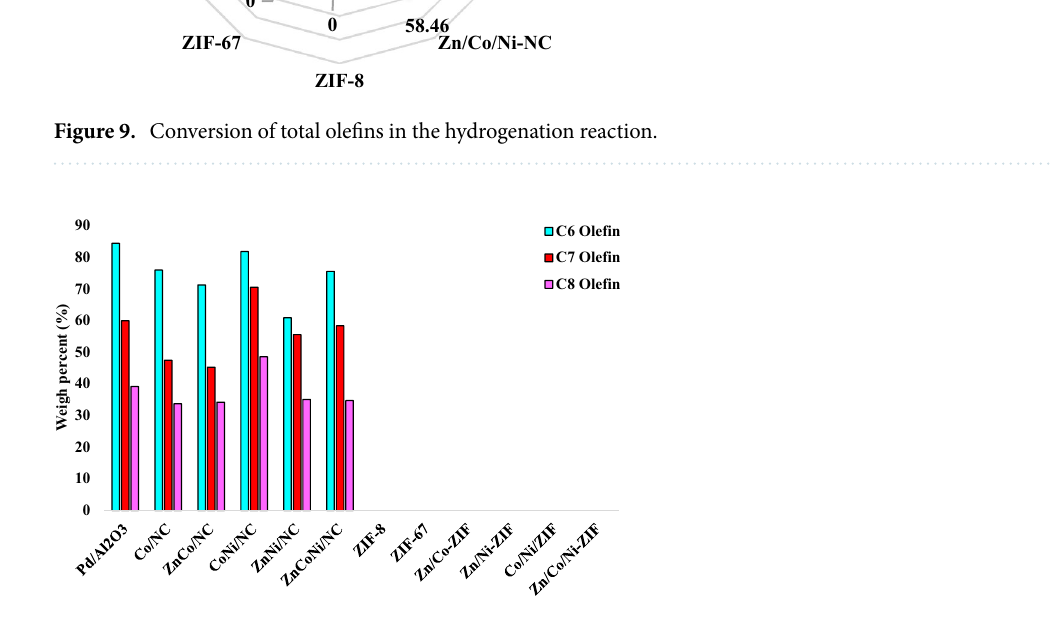
Figure 10. Conversion of C 6 , C 7, and C 8 in the hydrogenation